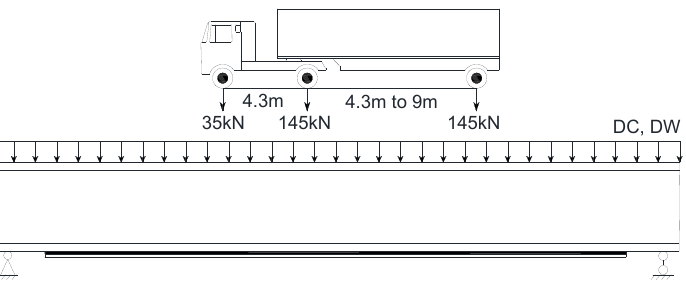
Figure 1. Detail of loads carried by strengthened steel I-girder.